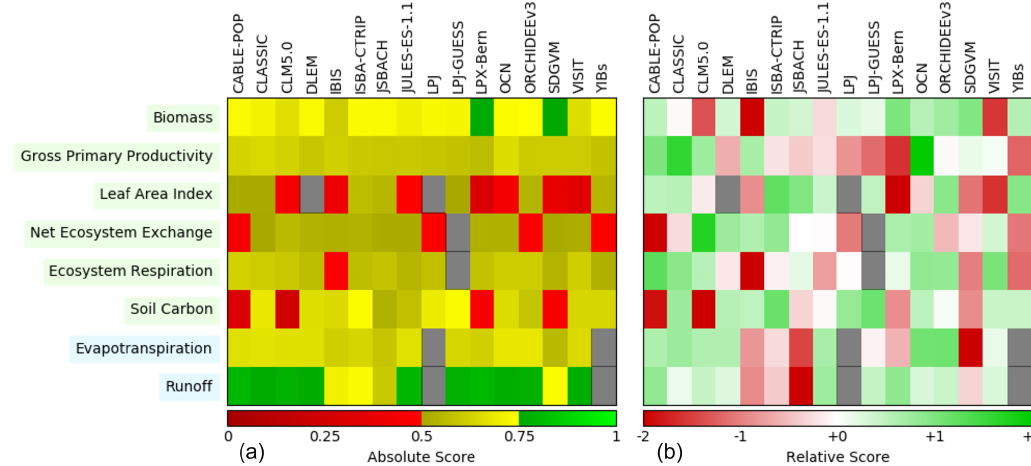
Figure B3. Evaluation of the DGVMs using the International Land Model Benchmarking system (ILAMB; Collier et al., 2018) (a) absolute skill scores and (b) skill scores relative to other models. The benchmarking is done with observations for vegetation biomass (Saatchi et al., 2011; and GlobalCarbon unpublished data; Avitabile et al., 2016), GPP (Jung et al., 2010; Lasslop et al., 2010), leaf area index (De Kauwe et al., 2011; Myneni et al., 1997), net ecosystem exchange (Jung et al., 2010; Lasslop et al., 2010), ecosystem respiration (Jung et al., 2010; Lasslop et al., 2010), soil carbon (Hugelius et al., 2013; Todd-Brown et al., 2013), evapotranspiration (De Kauwe et al., 2011), and runoff (Dai and Trenberth, 2002). For each model–observation comparison a series of error metrics are calculated, scores are then calculated as an exponential function of each error metric, and finally for each variable the multiple scores from different metrics and observational datasets are combined to give the overall variable scores shown in (a) . Overall variable scores increase from 0 to 1 with improvements in model performance. The set of error metrics vary with dataset and can include metrics based on the period mean, bias, root mean squared error, spatial distribution, interannual variability, and seasonal cycle. The relative skill score shown in (b) is a Z score, which indicates in units of standard deviation the model scores relative to the multi-model mean score for a given variable. Grey boxes represent missing model